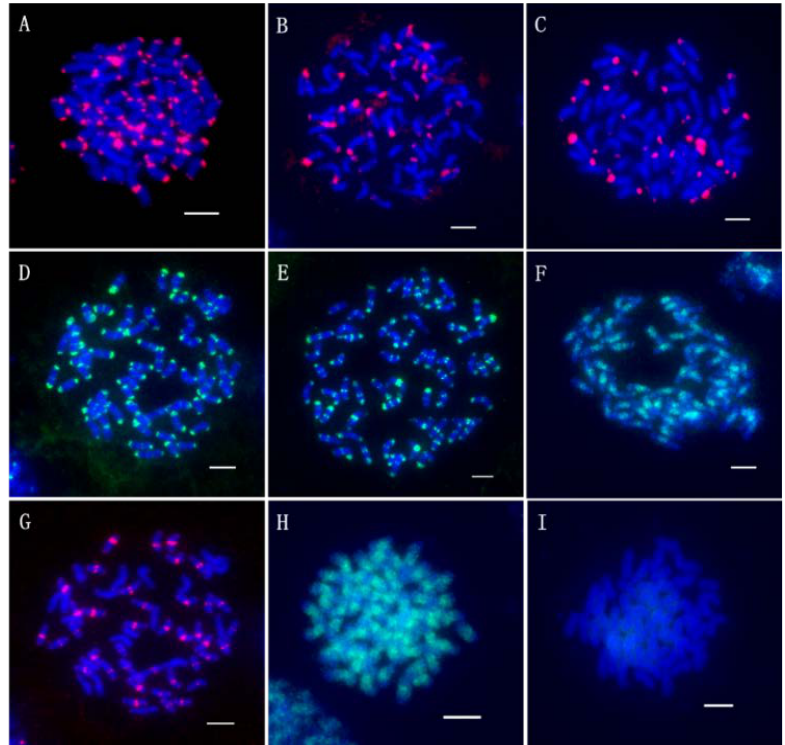
Figure 3. FISH result of the different probes. ( A ): Two ends of chromosomes; ( B ): The end of a part of chromosomes; ( C ): The end of most chromosomes and two ends of a part of chromosomes; ( D ): Two ends of chromosomes and the centromeric region of a part of chromosomes; ( E ): Two ends of chromosomes and the centromeric region of most chromosomes; ( F ): Diffuse distribute on all middle part of chromosomes; ( G ): The centromeric region of most chromosomes; ( H ): Diffuse distribute on all chromosomes; ( I ): No obvious signal. Scale bars = 5 μm.